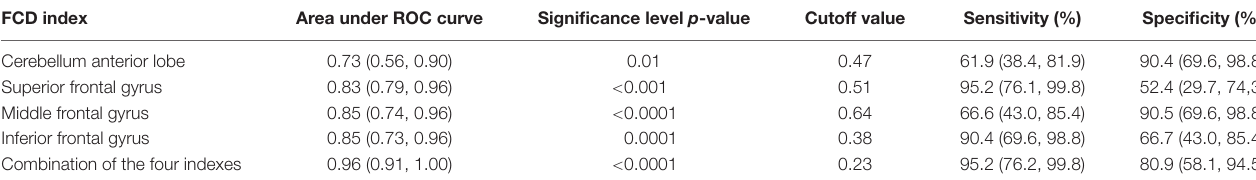
TABLE 3 | Discriminatory performance of the functional connectivity density.